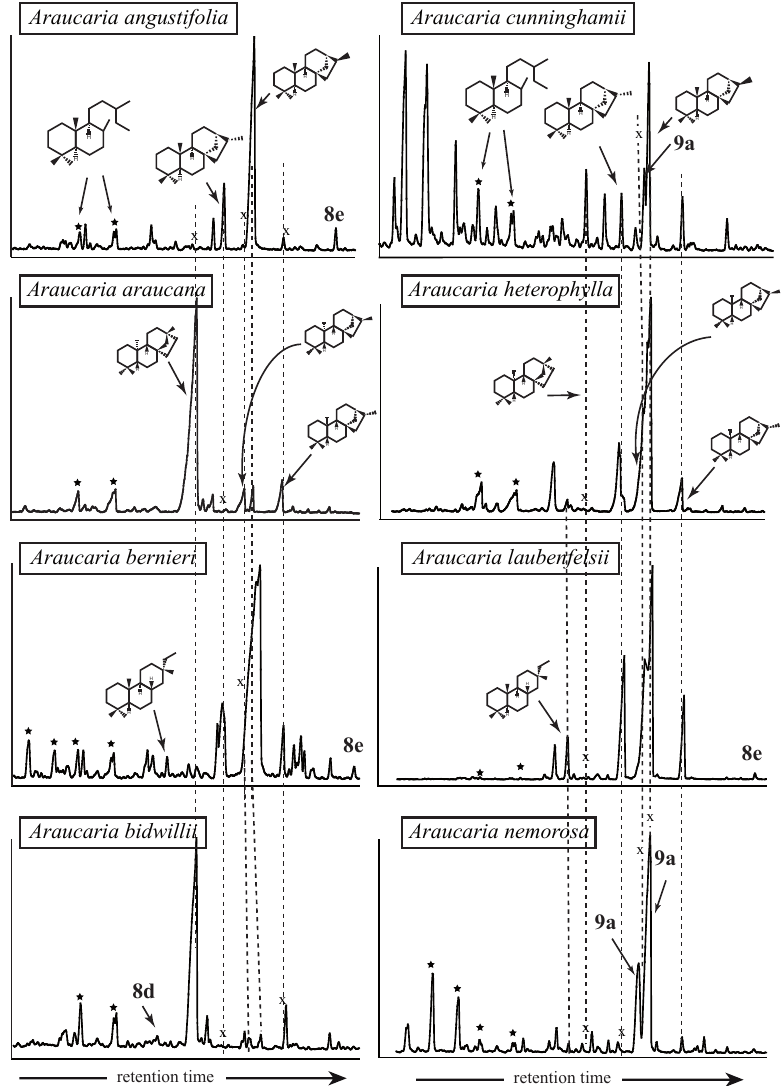
Fig. 6. Partial chromatograms (diterpenoids retention time window) of aliphatic fraction of pyrolysates of Araucaria species. The mass spectra of 8d and 8e are given in Fig. 8. The mass spectrum of 9a is given in Fig. 9. ? : labdanes; x : absence of compound.